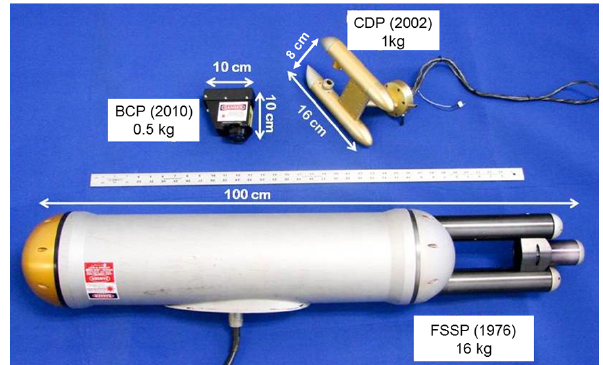
Figure 2. This photograph compares the backscatter cloud probe (BCP) with the forward scattering spectrometer probe (FSSP) and the cloud droplet probe (CDP) that were introduced 38 and 12 years ago, respectively. Figure 3. The backscatter cloud probe (BCP) is mounted with its window looking out through a transparent aperture as illustrated in these four photos, clockwise: (a) on an access hatch of the FAAM BAE-146; (b) on a hard point just behind the co-pilot and just ahead of the emergency exit of the University of North Dakota Cessna Ci- tation, inside the radio compartment; and (c) on a Lufthansa A340- 300 Airbus just behind and below the forward passenger access door – (d) a close-up photo of the BCP window on the Airbus.